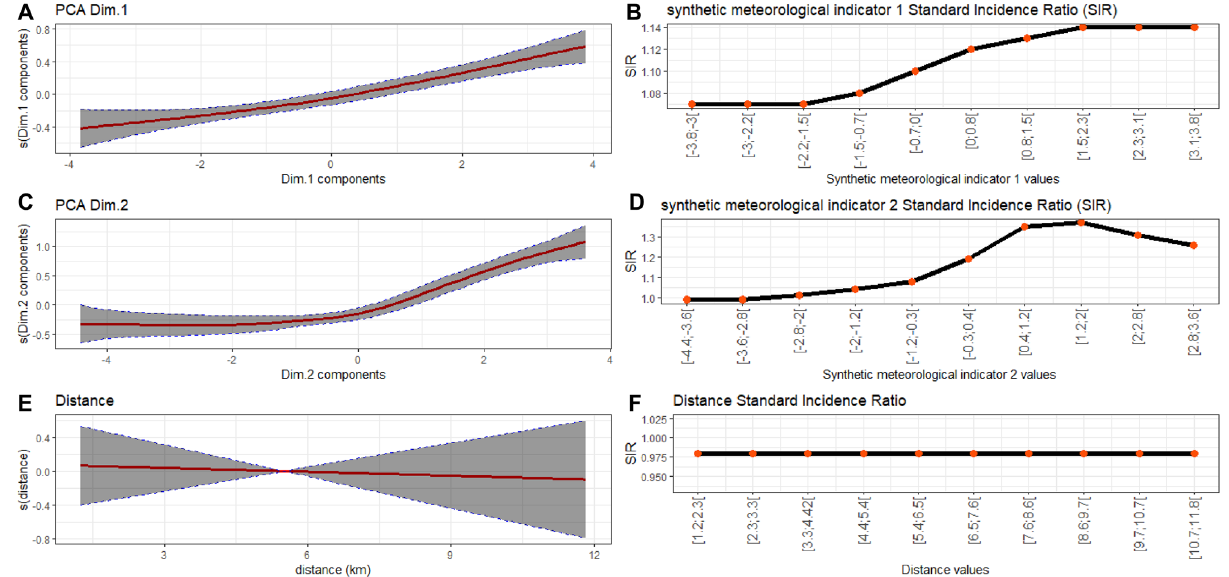
Figure 6. Relationship (red curve) between malaria cases and SMI1 ( A ), SMI2 ( C ), and Euclidean distance to health centre ( E ) with 95% confidence intervals (shaded area). Evolution of the standard incidence ratio (SIR) as a function of SMI1 (mainly correlated with precipitation variables) ( B ), SMI2 (mainly correlated with temperature variables) ( D ), and Euclidean distance to health centre ( F ).